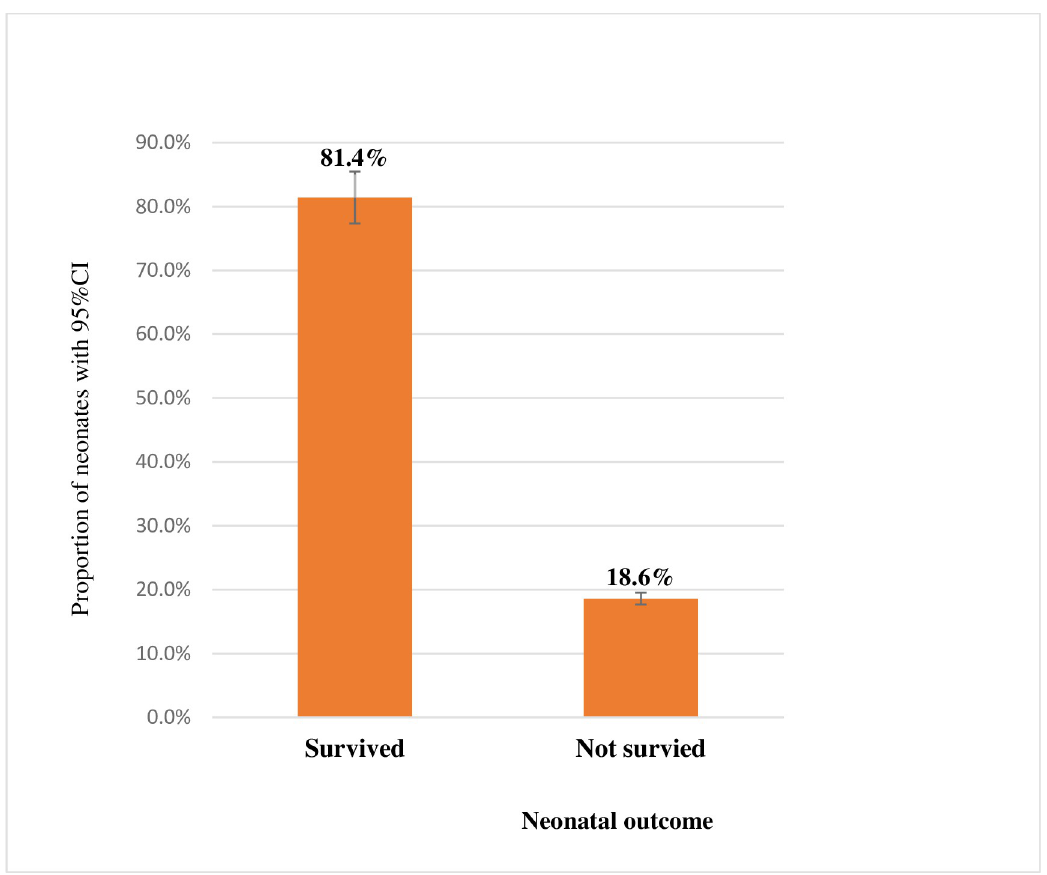
Fig 2. Magnitude of neonatal mortality among neonates admitted to neonatal intensive care unit in selected public hospitals in Somali Regional State, Eastern Ethiopia, 2020.